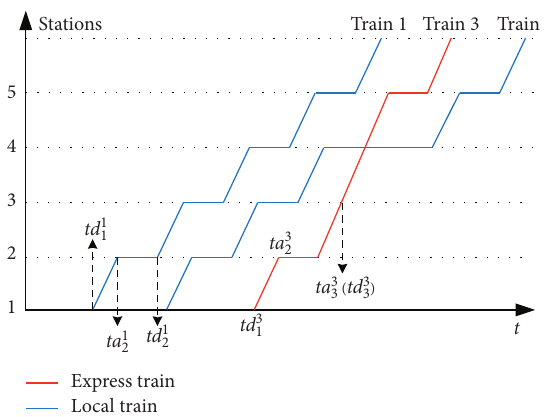
Figure 4: Illustration for train departure time and arrival time in express/local